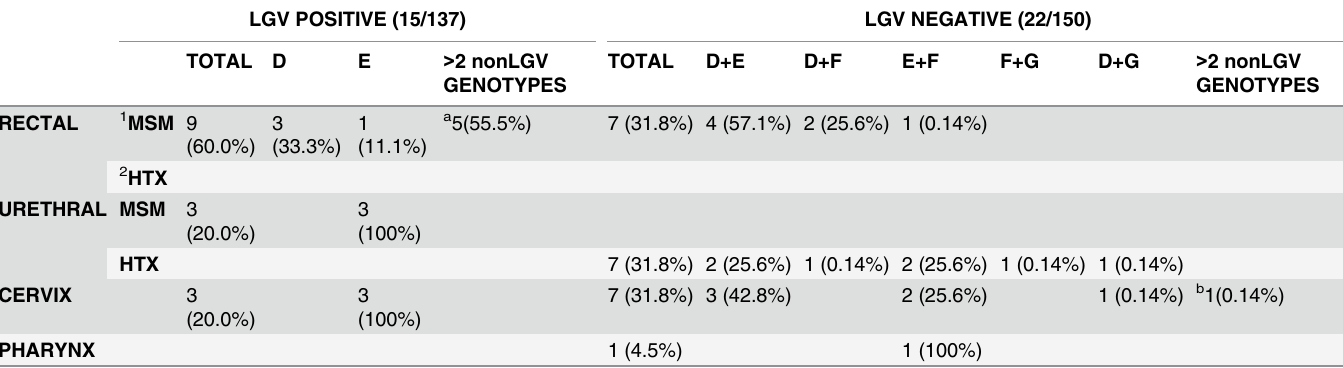
Table 1. Percentage of co-infections in patients with and without presence of LGV, depending on infection site.